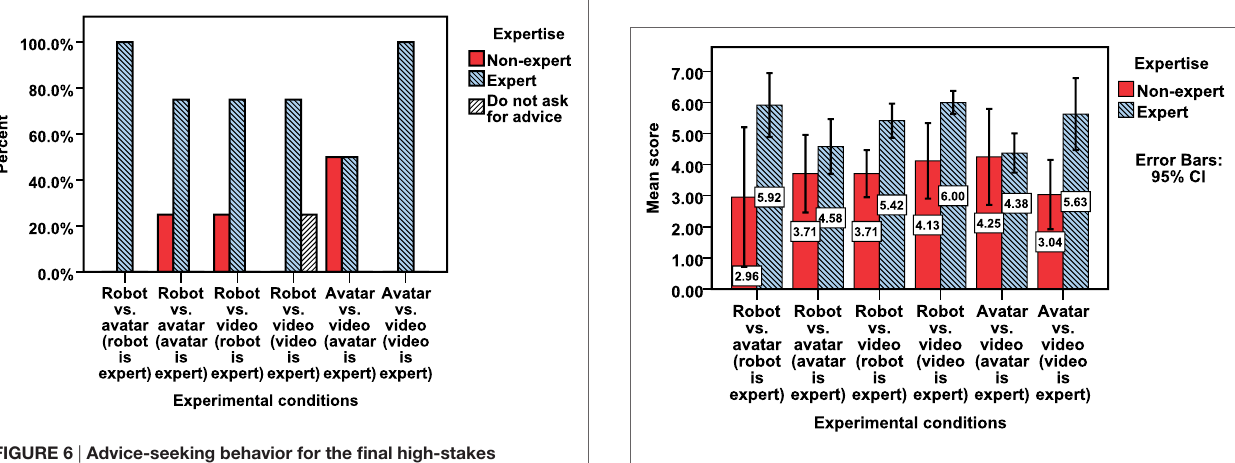
FigUre 7 | self-reported trust by experimental conditions .